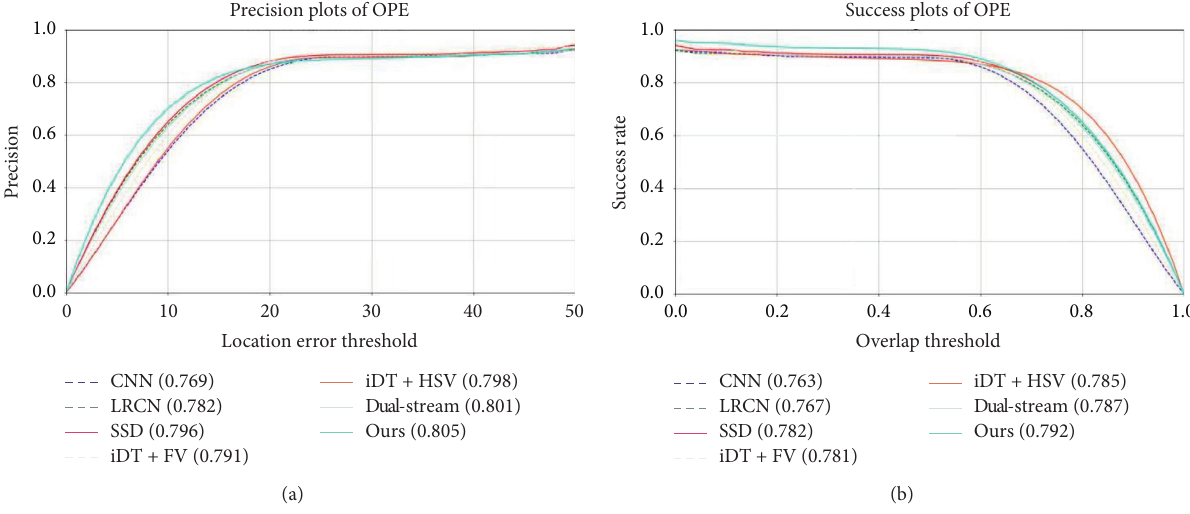
Figure 10: Comparison results of OTB100 with different methods: (a) accuracy rate; (b) success rate.